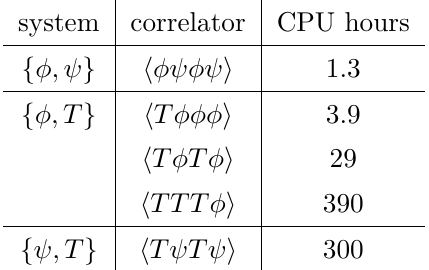
Table 5 : Estimates of CPU hours needed for the computation of dynamic blocks in each system of correlators (for one fixed choice of external dimensions). The notation for the correlators is the same as in table 2.